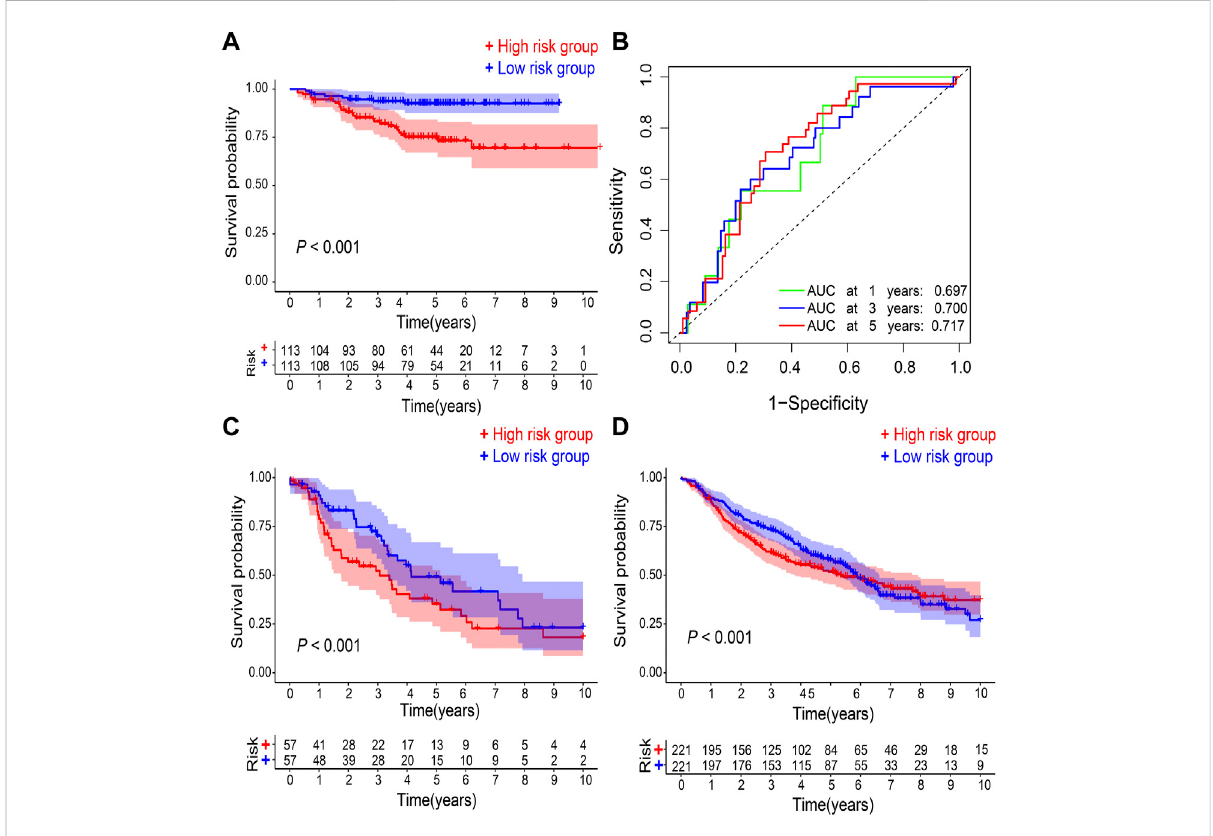
FIGURE 3 Validation of gene signature. (A) Kaplan – Meier survival analysis and (B) ROC curve analysis in GSE31210. Kaplan – Meier survival analysis in (C) GSE26939 and (D) GSE68465, respectively. ROC, receiver operating characteristic. AUC, an area under the ROC